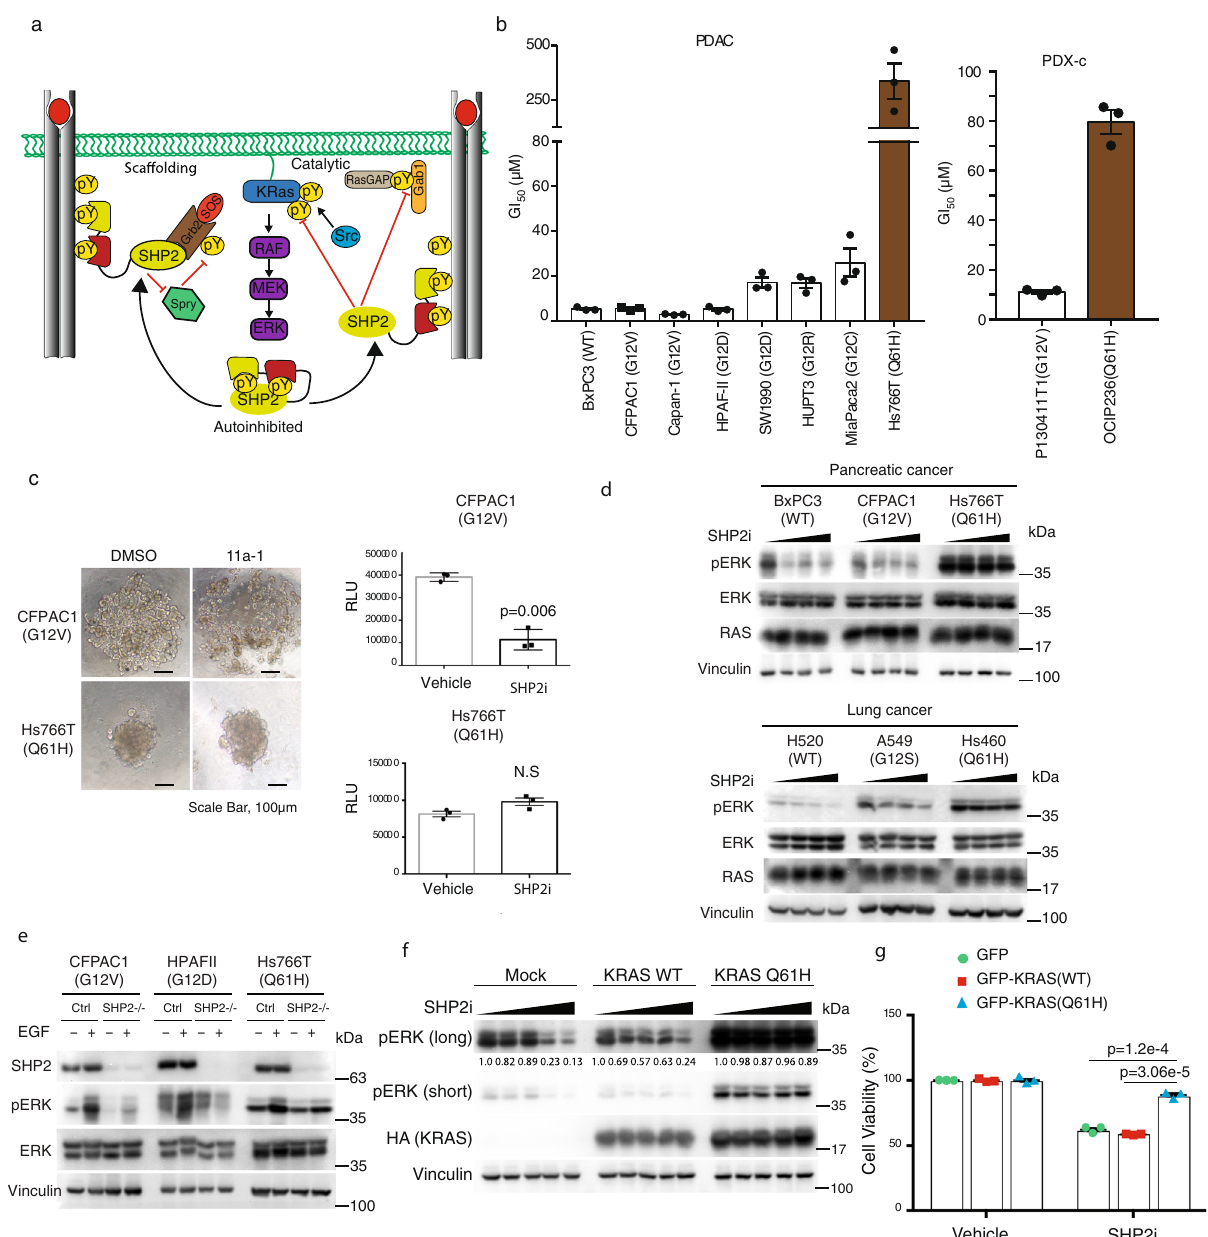
Fig. 1 KRAS Q61H mutant cells exhibit insensitivity to pharmacologic inhibition of SHP2 (SHP2i). a Schematic cartoon illustrating proposed catalytic and scaffolding roles of SHP2 in modulating KRAS signaling. SHP2 scaffolds the GRB2:SOS complex to activated receptor tyrosine kinases to promote RAS activation, whereas its phosphatase activity inhibits Sprouty ’ s negative regulation of SOS (left) and dephosphorylates a pTyr docking site for p120RASGAP on GAB1, thereby reducing inactivation of KRAS (right). Top: SHP2 also dephosphorylates KRAS, release it from the “ dark state ” and restoring KRAS signaling. b PDAC cell lines (left) or PDX cells (right) were plated in 96-well plates in triplicate, treated with increasing concentrations of the SHP2 inhibitor 11a-1 for 48h, then cell viability was determined using alamarBlue. GI 50 values were determined using GraphPad Prism 6.0. Data represent mean±SEM of three independent experiments. c CFPAC1 or Hs766T cells were seeded at 1000 cells/well in 96-well spheroid microplates. Spheroids were cultured for 48h and then exposed to vehicle (DMSO) or 50 μ M 11a-1. Following 48h incubation with 11a-1, a 3D cell viability assay was performed. Left: representative images obtained using a VWR Vista Vision inverted microscope. Scale bar, 100 μ m. Right: data represent mean±SEM. RLU (relative light units) of three independent experiments. To compare the 11a-1-treated and control group, p -value was generated using two-tailed Student ’ s t -test. d PDAC or lung cancer cell lines were treated with the increasing concentrations of the SHP2 inhibitor SHP099 (0, 5, 10, 20 µ M) for 2h. Equal amounts of lysates were resolved on SDS-PAGE and immunoblotted with the indicated antibodies. e CRISPR/ Cas9-mediated non-target (Ctrl) or SHP2 − / − CFPAC1, HPAF-II, and Hs766T cells were serum-starved and treated with ( + ) or without ( − ) EGF (10ng/ml). Equal amounts of lysates were immunoprecipitated and immunoblotted with the indicated antibodies. f HEK293 cells were transfected with mock, HA-KRAS WT, or HA- KRAS Q61H plasmids, as indicated. Cells were cultured for 48h and then exposed to increasing concentrations of SHP099 (0, 2, 5, 10, 20 µ M) for 2h. Equal amounts of lysates were resolved on SDS-PAGE and immunoblotted with the indicated antibodies. Numbers indicate pERK levels normalized to vinculin based on Data represent mean±SEM of three independent experiments. The GFP and GFP-KRAS WT groups were independently compared with GFP-KRAS Q61H group using two-tailed Student ’ s t -test. The respective p -values are indicated on the fi gure. d – f The blots are representative of three independent